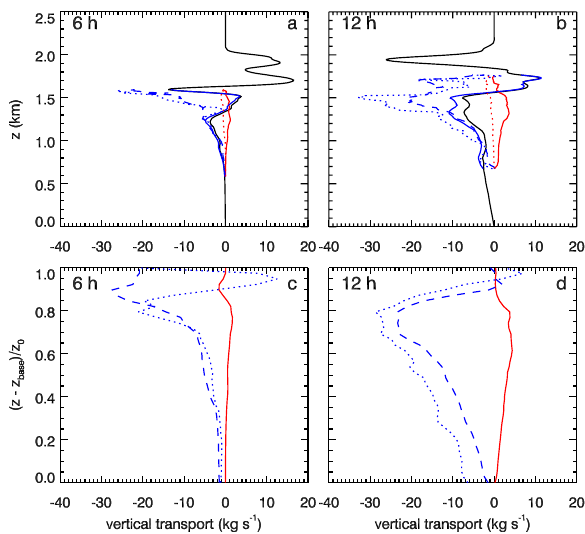
Fig. 5. As in Fig. 2, but for case 2, where tracers are released into the initial inversion layer at